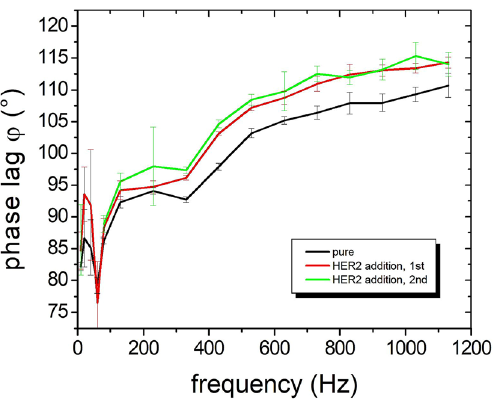
Figure 7. Demonstration of the phase lag increase of 5-layer nanoprobes functionalized by sHER2 antibodies on addition of sHER2 proteins (sHER2 assay). The nanoparticle concentration is 10 pM and the oscillating magnetic field amplitude is 5 mT. The binding sHER2 proteins are added twice.